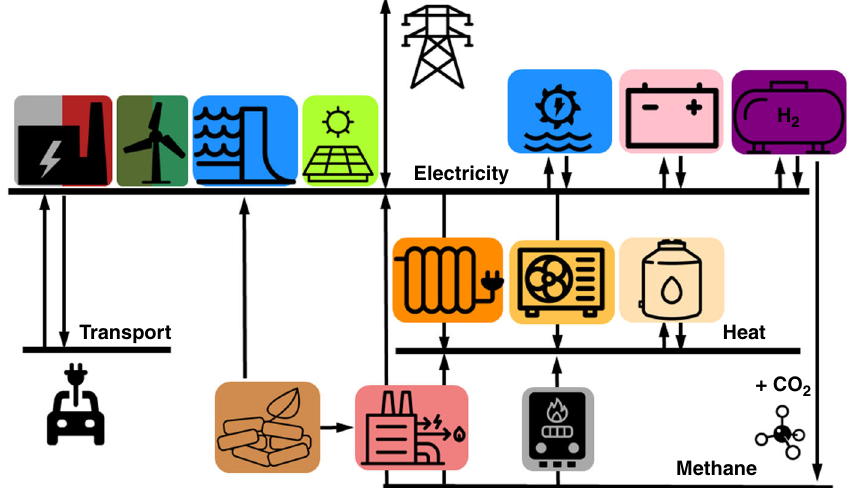
Fig. 8 Model diagram representing the main generation and storage technologies in every country. Electricity can be produced with conventional power plants (nuclear, coal, lignite and gas), reservoir and run-of-river hydro, as well as solar PV, onshore and offshore wind. It can be stored in pumped hydro storage, battery and hydrogen storage. Heating can be supplied via heat resistors, heat pumps and gas boilers. It can be stored in thermal energy storage. Combined heat and power (CHP) can use methane and biomass. Electrolytic hydrogen can be combined with direct air capture CO 2 to produce synthetic methane. When the transport sector is included, half of the battery electric vehicles allow smart charging and a quarter provide vehicle-to-grid